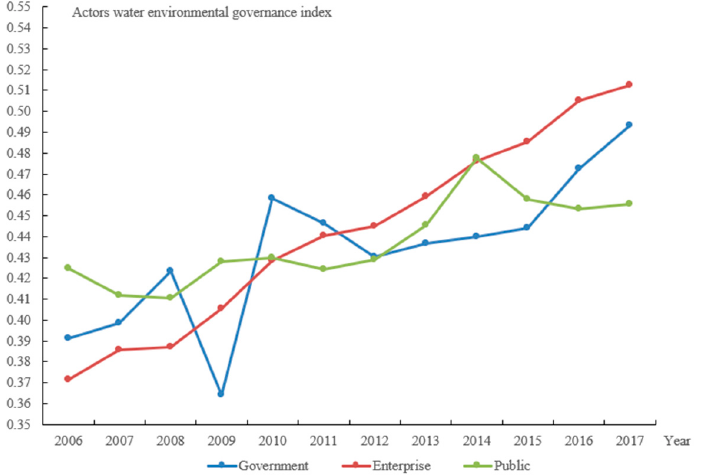
Figure 3. Water environmental governance index for synergistic actors in the Yangtze River Delta. Figure 3. Governance index of water environment for synergistic actors in the Yangtze River